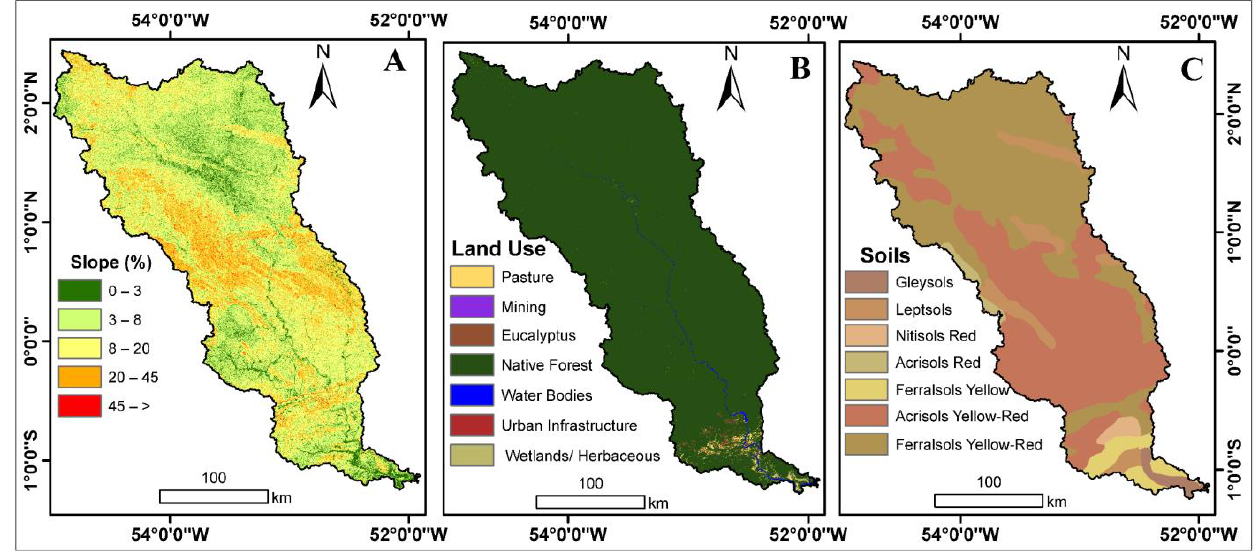
Figure 3. Spatial distribution of input data used to run SWAT for the Jari River Watershed. Slope ( A ), Land Use and Land Cover ( B ), and Soils ( C ).